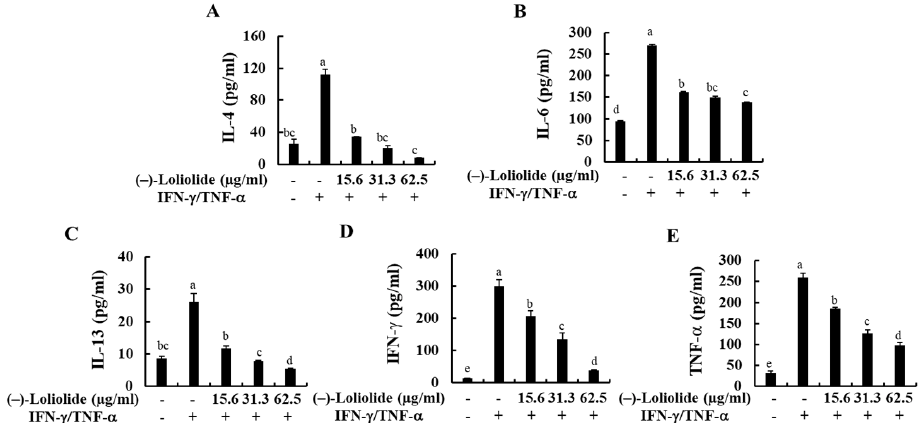
Figure 3. Inhibitory effects of (–)-loliolide on IFN- γ /TNF- α -induced production of inflammatory cytokines ( A – E ) in HaCaT keratinocytes. The results represent data from three independent experiments (n = 3), and the values are indicated as the mean ± SE. Error bars with different letters are significantly different ( p < 0.05).